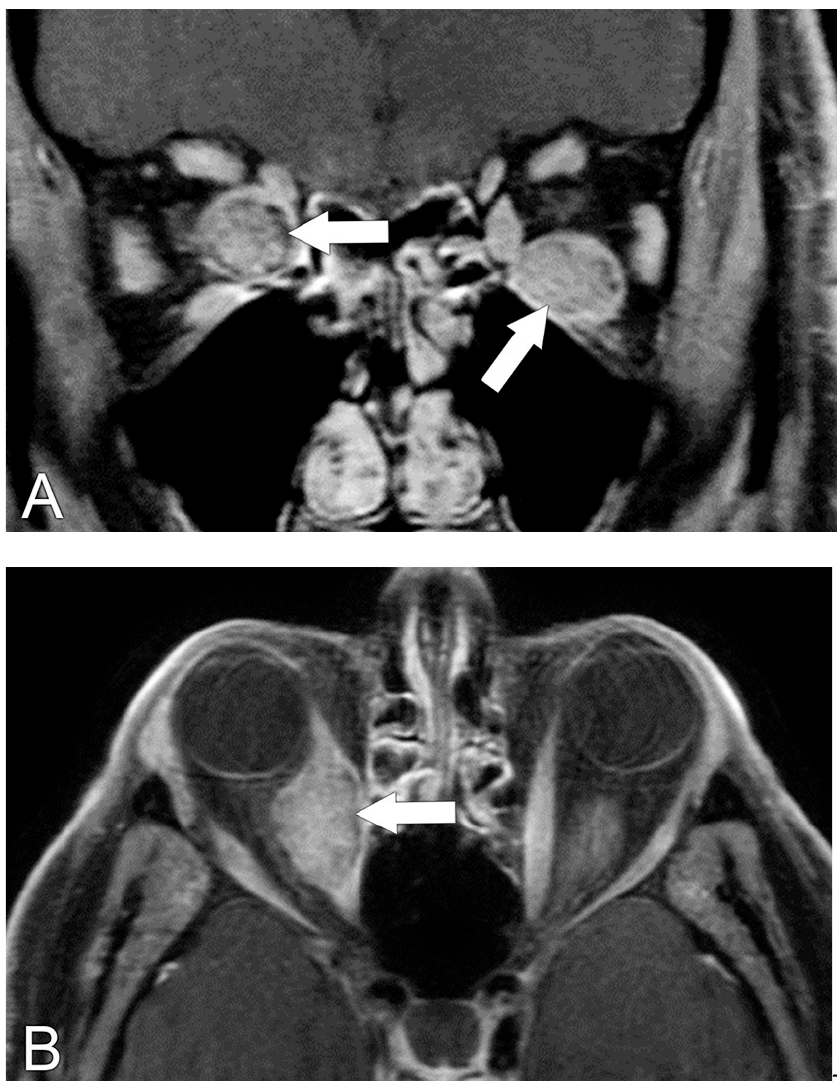
Figure 8. Gastrointestinal carcinoid tumor metastatic to the extra-ocular muscles. ( A ) Coronal T1 post-contrast MRI sequence shows heterogeneously enhancing metastases to the right medial and left inferior rectus muscles (arrows). ( B ) Axial T1 post-contrast sequence shows a nodular appearance of the right medial metastasis